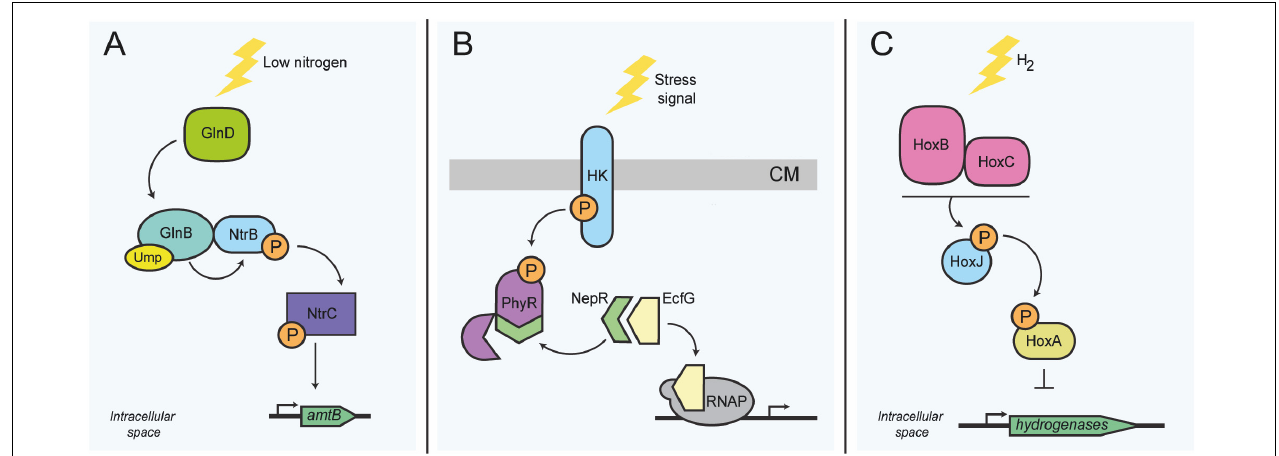
FIGURE 3 | Activity sensing in intracellular bacterial functions related to metabolism. (A) Nitrogen stress response in E. coli . At low nitrogen levels, GlnD uridylates GlnB. GlnB-UMP subsequently activates the TCS NtrB/NtrC. The intracellular kinase NtrB autophosphorylates, and in turn phosphorylates the DNA-binding transcriptional regulator NtrC; activation of NtrC is needed for the transcription of several genes, including amtB . (B) Transcription control switch of the general stress response in alphaproteobacteria. Stress sensing activates autophosphorylation of the histidine kinase, which in turn phosphorylates the regulator protein PhyR. Phosphorylation of PhyR induces its conformational change, allowing the sequestration of the anti-sigma factor NepR, consecutively releasing the transcriptional regulator sigma-EcfG, which permits the transcription of general stress response genes. (C) H 2 sensing in R. eutropha . Expression of genes required for the synthesis of hydrogenases is controlled via sensing of molecular hydrogen by the intracellular Ni 2 + Fe 2 + hydrogenases HoxB and HoxC, which then interact presumably with the histidine kinase HoxJ. HoxJ, when activated by HoxBC, prevents HoxA-mediated transcription of several hydrogenase genes (horizontal line). HK, histidine kinase; RNAP, RNA polymerase; CM, cytoplasmic membrane; P, phosphoryl group; UMP, Uridine monophosphate group. The top of panel B points to the outer face of the bacterial envelope.